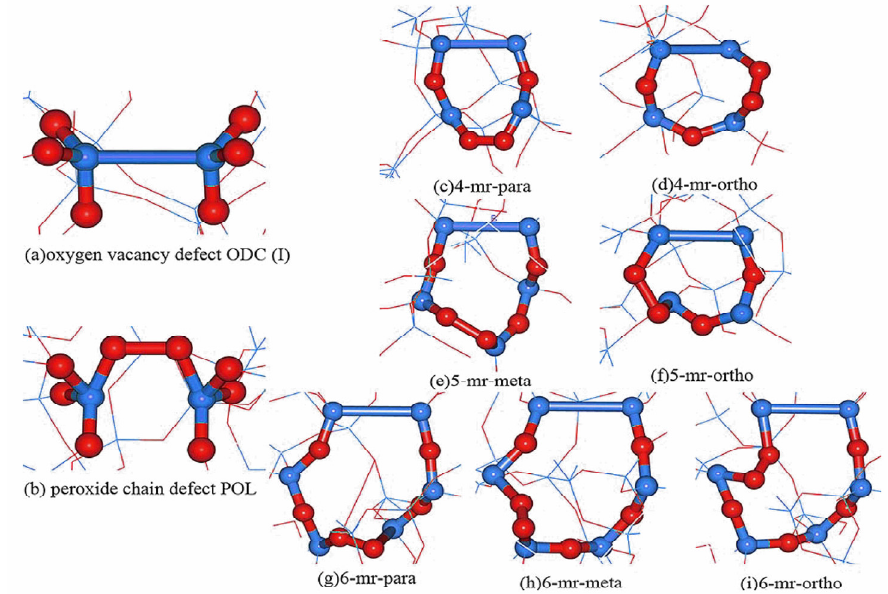
Figure 1. ( a ) oxygen vacancy defect ODC(I) Structure diagram ( b ) peroxide chain defect POL Structure diagram. ( c – i ) are the Co-doping model of peroxy bond defect (POL) and oxygen vacancy defect (ODC(I)), ( c , d ) are the para-position and ortho-position models of two defects in a 4-membered; ( e , f ) are the meta-position and ortho-position models of two defects in a 5-membered ring: ( g – i ) are the para-position, meta-position and ortho-position models of two defects in a 6-membered ring. Blue ball is silicon atom, red ball is oxygen atom. The formation can be used to illustrate how changing it is to combine two model